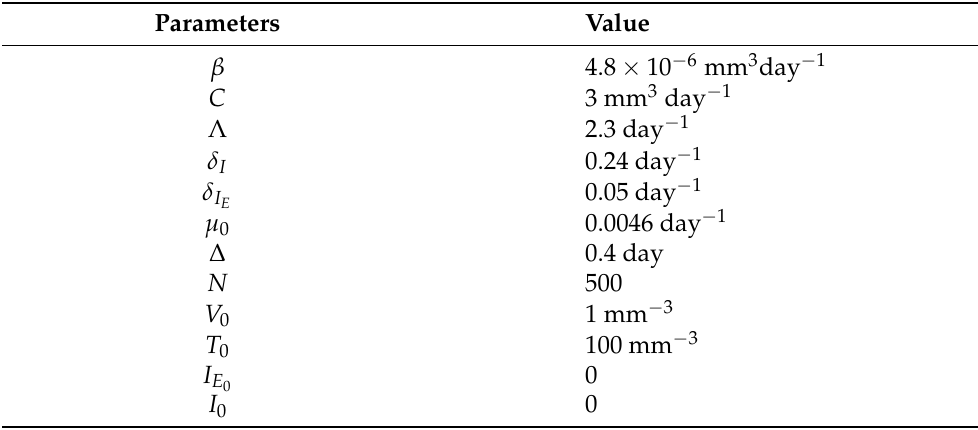
Table 1. Parameter values for the numerical simulations when R 0 <